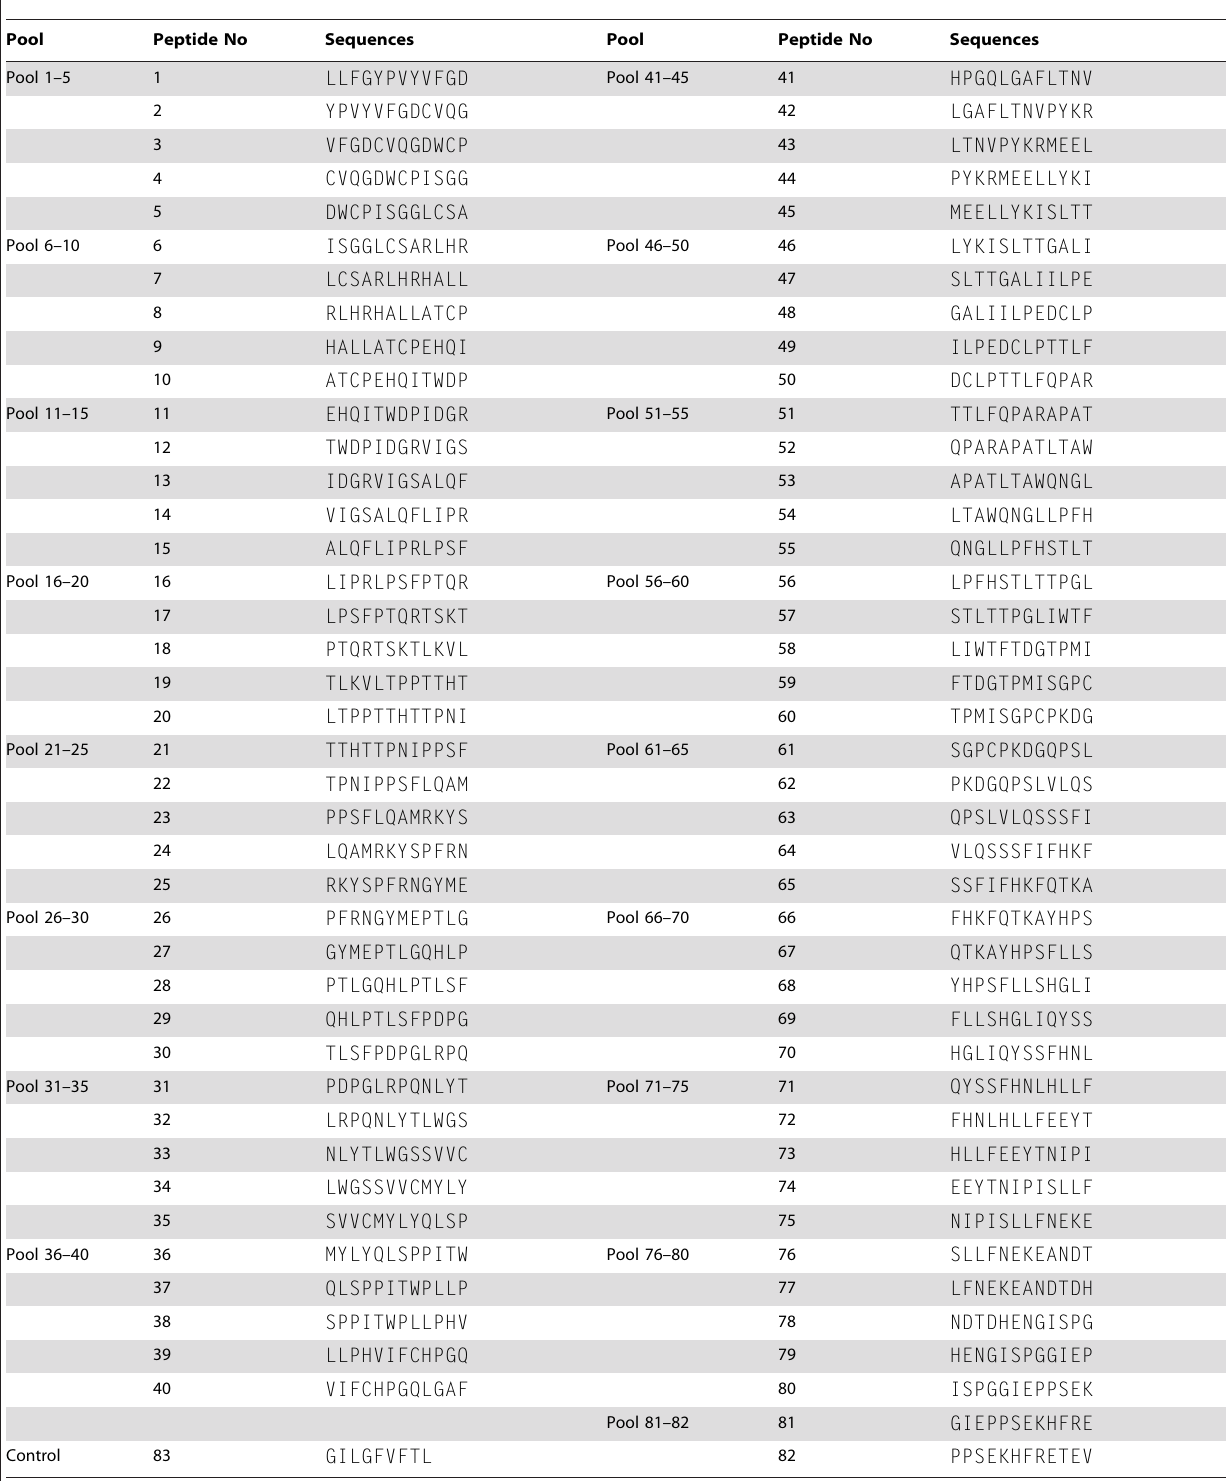
Table 2. Pools of 82 overlapping peptides (12-mers) covering the entire STLV-1 Tax protein, used for stimulation in vitro of PBMCs from STLV-1-infected